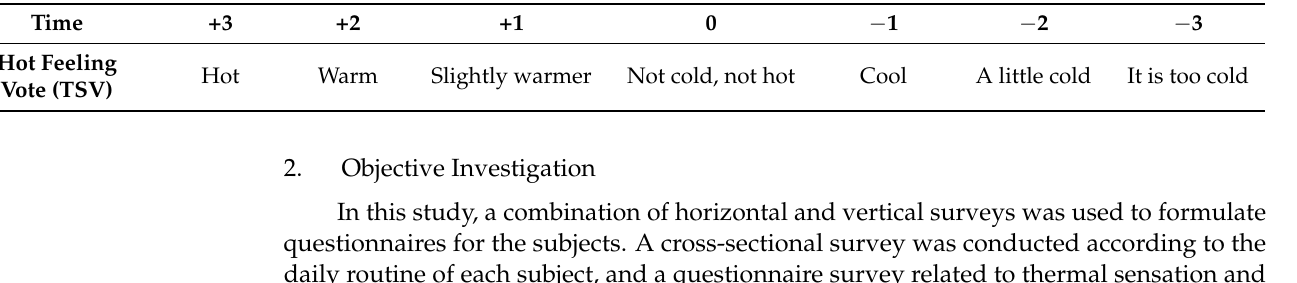
Table 2. Thermal sensory voting division.